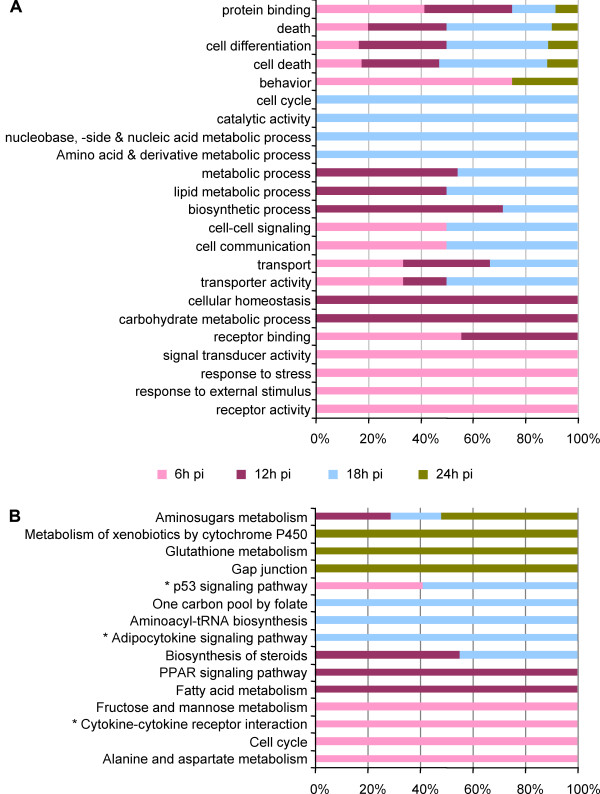
Gene set enrichment analysis. (A) Gene Ontology enrichment analysis (p < 0.01) based on GOslim. Genes found significant in the analysis were grouped by function following GO annotation. The stacked bars show the contribution of each time point across categories. Time points are colored as indicated on the graph. (B) KEGG metabolic pathway enrichment analysis calculated using the DEG having a KEGG annotation. Significantly enriched pathways are marked with a * (for p < 0.01).